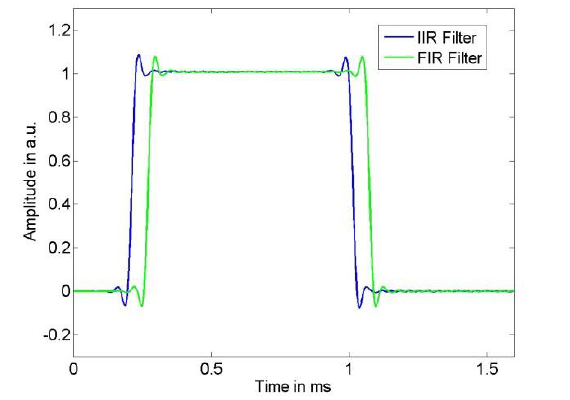
Figure 4. The compensated output signals resulting from the IIR and the FIR compensation filter for the narrow-banded sensor input